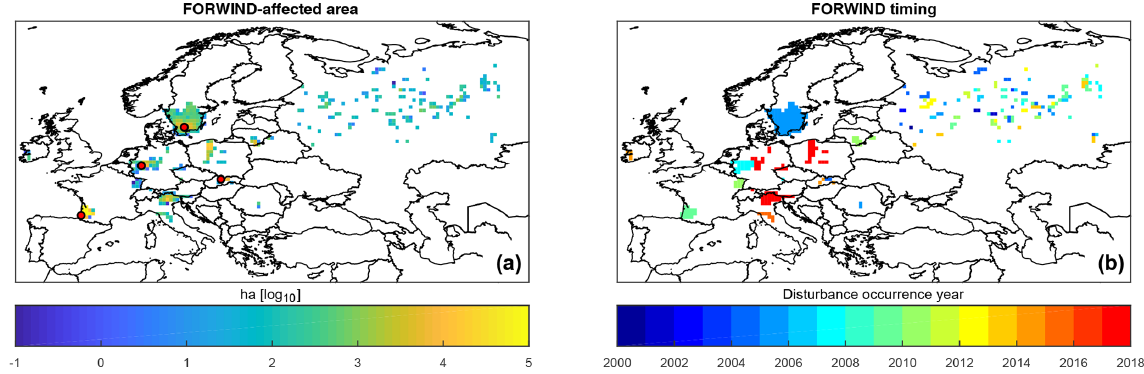
Figure 1. Spatial and temporal distribution of wind disturbances in the FORWIND database. (a) The total area affected by wind disturbances over the multi-year observational period (2000–2018) in 0.5 ◦ cells. (b) Wind disturbance occurrence year in the same cells. Red circles in (a) refer to site locations shown in Fig. 2.